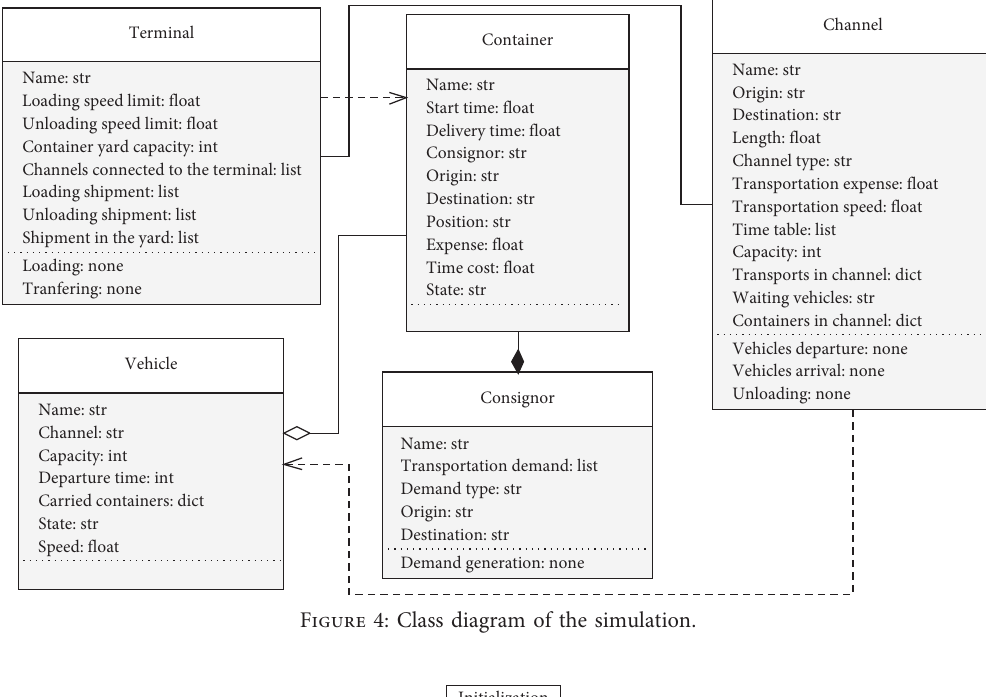
Figure 4: Class diagram of the simulation.